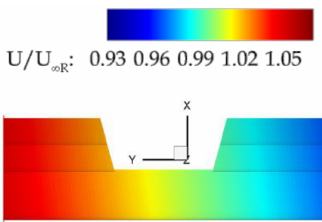
Figure 18. Contour showing the freestream velocity distribution on the wing under the cornering condition.